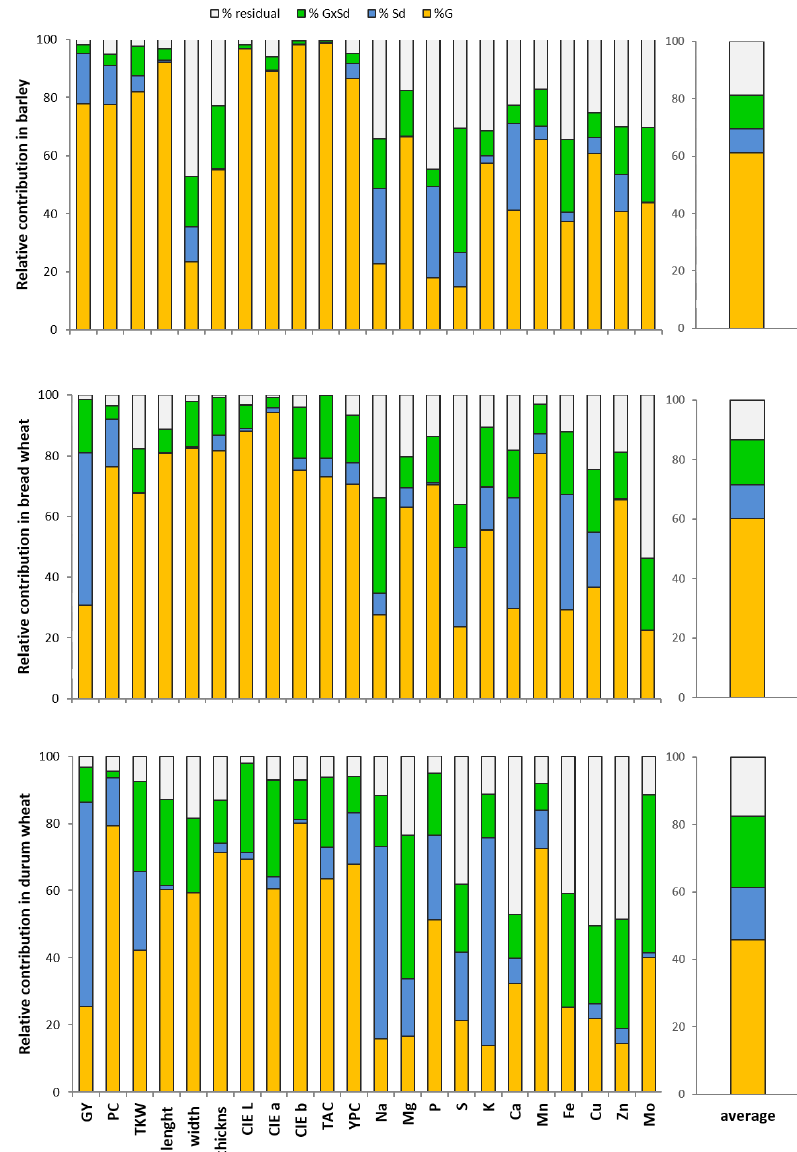
Figure 2. Percentages of the contributions of G, Sd and G x Sd to the variability for all the parameters for each species (barley, bread wheat, durum wheat).